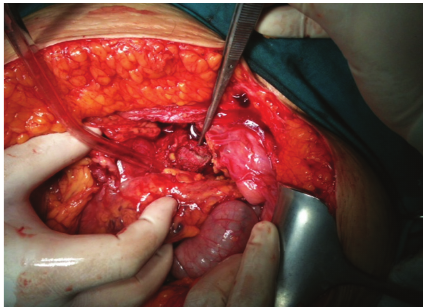
Figure 2: Exploratory laparotomy revealed an encapsulated sponge surrounded by omentum.